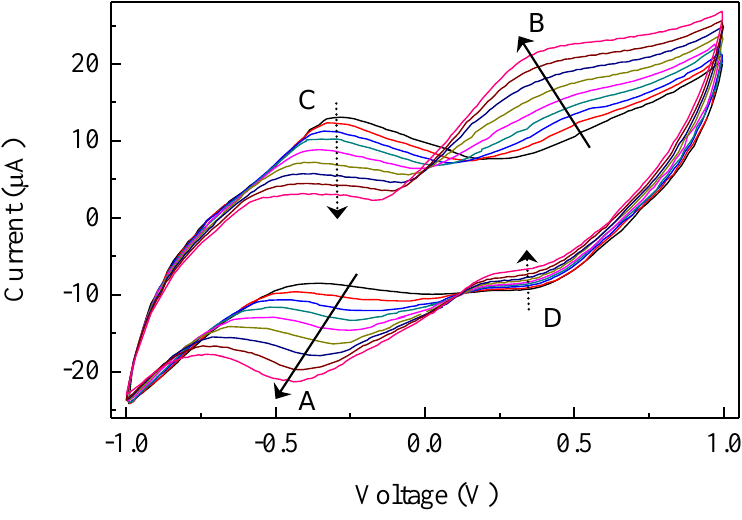
Figure 7. Current-voltage cycles of a typical Au/Nafion/MWNTs-Nafion:Cu/Au cell Gold/Nafion:Polypyrrole/ MWCNTs device, measured in distilled deionized water (black line), and in the presence of PAP that increases in steps of 2 × 10 −7 M. Scan rate is 50 mV/s. The dashed arrows indicate how the original current peaks progressively decrease with exposure to increasing analyte concentration. The solid arrows indicate the new peaks that arise and grow in response to increased PAP concentration.